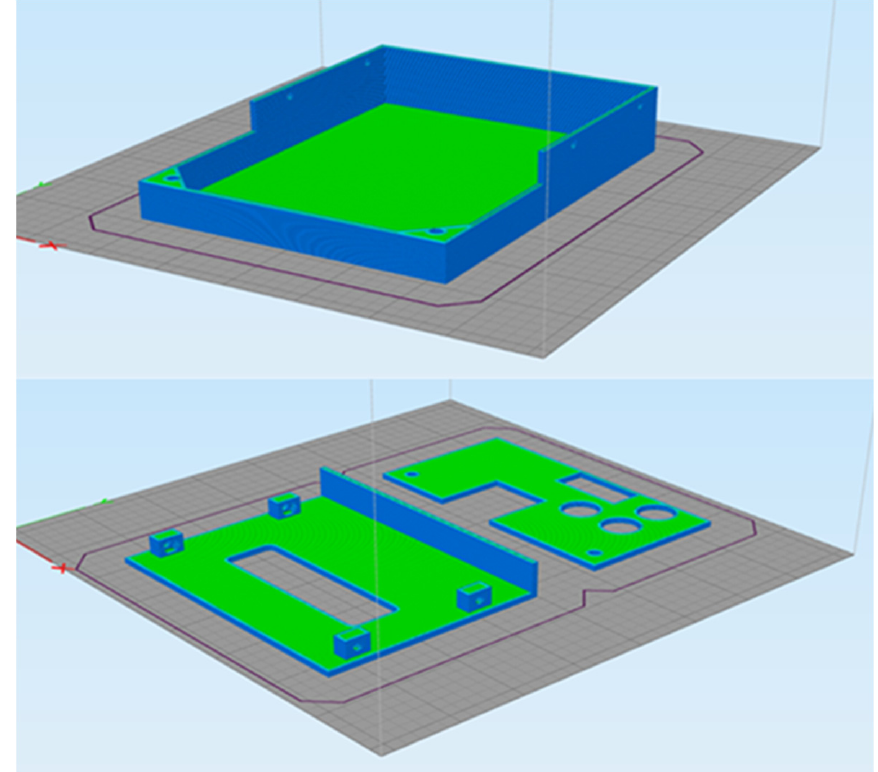
Figure 9. Slicing process of the electronic circuit packaging base.